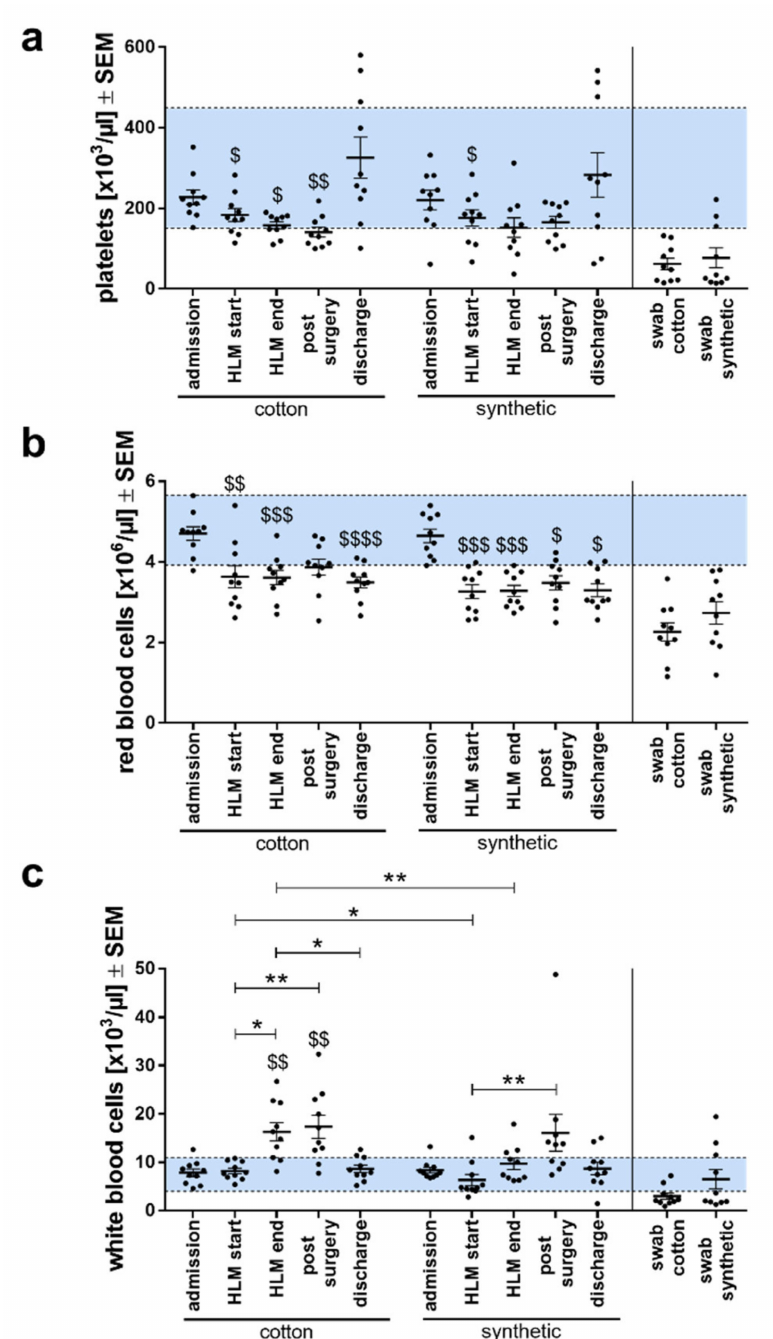
Figure 2. Analyses of blood cell counts of both patient groups (cotton swabs and synthetic swabs) measured at time of admission, during (HLM start, HLM end, and swab), and post-surgery as well as before discharge. ( a ) Platelets, ( b ) red blood cells, ( c ) white blood cells. Cell counts are presented as means ± SEM per study group. The horizontal line indicates the threshold values to pathological levels, the blue areas between the lines indicate the physiological ranges. Differences between groups were analyzed using Student’s t -test, differences within groups were analyzed using a one-way analysis of variance (ANOVA) with Bonferroni’s multiple comparison post-hoc test. The symbol “$” denotes significant differences compared to admission. * or $ p < 0.05; ** or $$ p < 0.01; $$$ p < 0.001; $$$$ p <